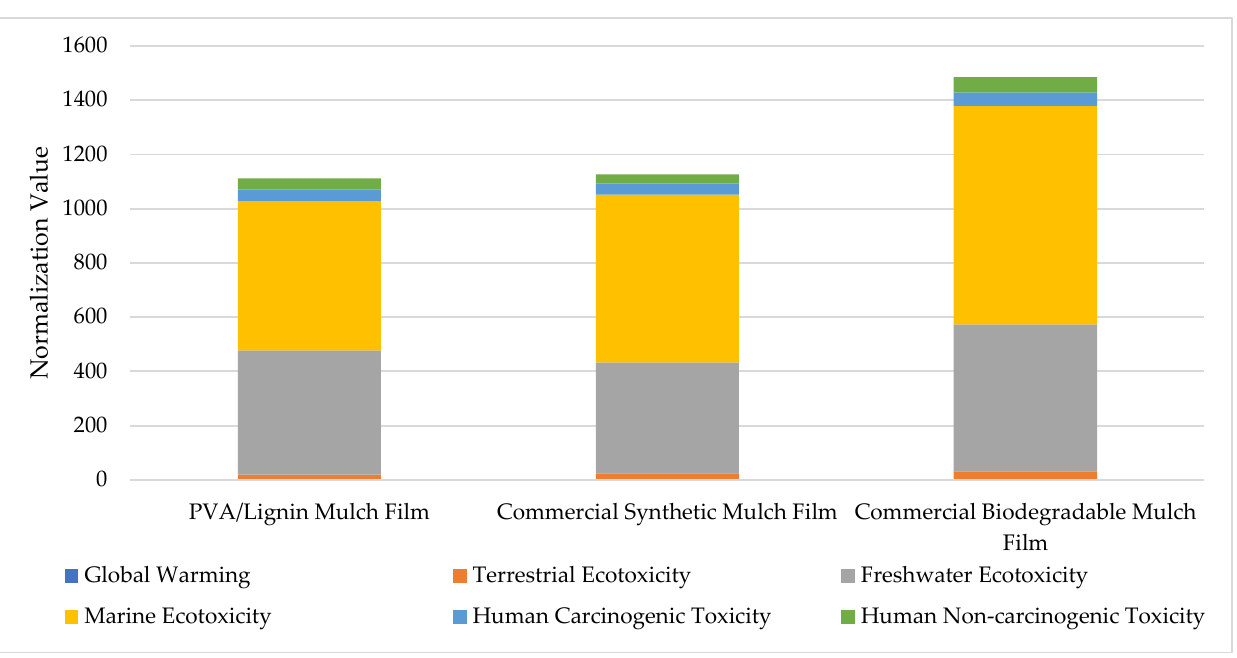
Figure 13. Midpoint impact categories of mulch film PVA with lignin (40PVA/60LN) compared to PVA mulch film, commercial, synthetic, and biodegradable mulch films, based on the ReCipe Midpoint (H)